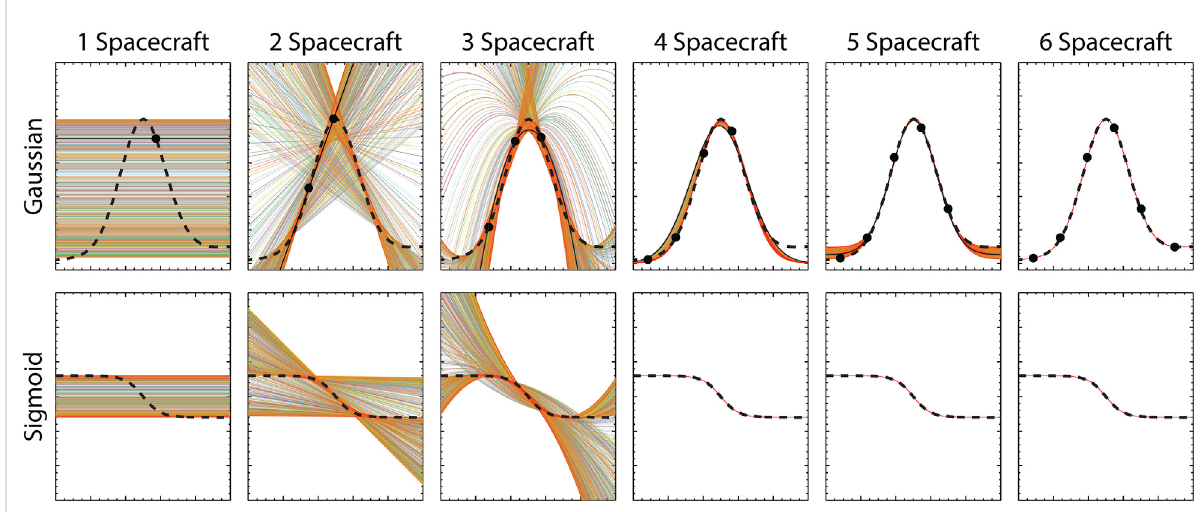
FIGURE 10 Randomizedplacementofafour-spacecraftconstellationthroughoutbothaGaussian(toprow) andSigmoidal(bottomrow) distribution allow for different functional fi ts. Filled in circles in the top row are examples of the 1,000 random placements of spacecraft constellations resulting in the shown colored fi ts. The solid black curve on the top row is the corresponding fi t from the shown example placements. The initial distribution the fi ts are attempting to recreate is shown by the dashed curve. Four spacecraft are the optimal bene fi t-to-cost con fi guration for mesoscale